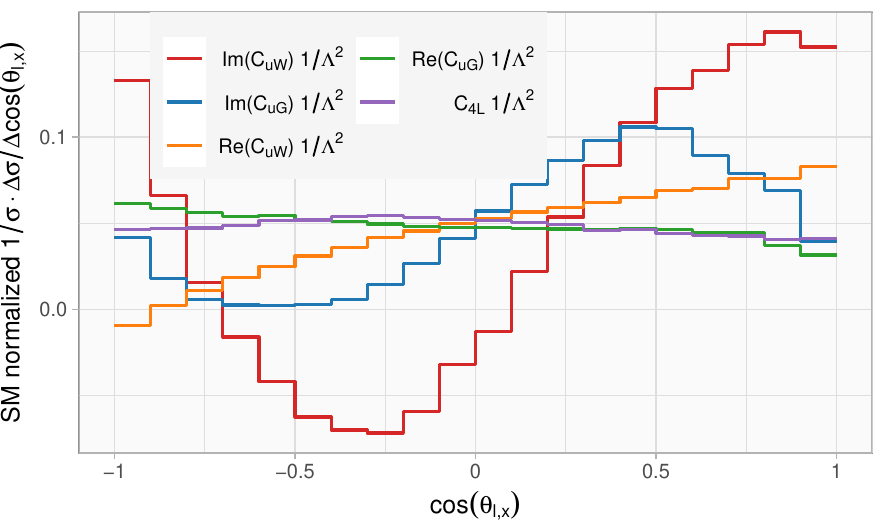
Figure 13. To itself and to the SM normalized SMEFT contributions to the cos (cid:18) l;x distribution at NLO in QCD . Results are presented for the real and imaginary parts of C 33 as for the four quark operator C 4 L